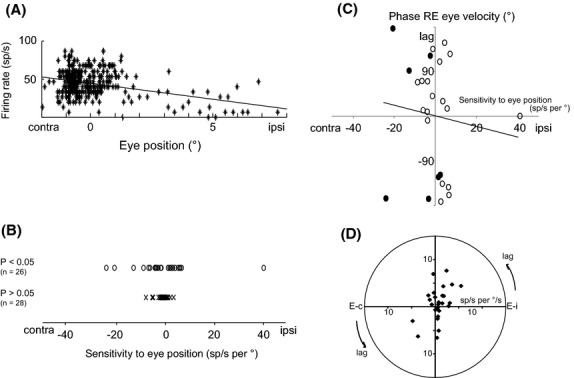
Sensitivity of Purkinje cells to eye position. (A) Example of a Purkinje cell with significant correlation between firing rate and eye position. Measurements were made during the spontaneous eye movements made by the mice while restrained with the head stationary in total darkness. Each point represents the average firing rates and eye position measured during a single, 150-ms period. Positive values on the x-axis indicate eye position ipsiversive to the recording site. The line indicates the linear regression between firing rate and eye position. (B) P-values and slopes of the linear regression between firing rate and eye position for each Purkinje cell tested. Twenty-six of fifty-four Purkinje cells showed significant correlation between firing rate and eye position. (C) The phase of firing relative to ipsiversive peak eye velocity during the OKR (ordinate), plotted as a function of the sensitivity to eye position (abscissa), in the 26 Purkinje cells with significant eye position sensitivity (ovals in panel B). Open and filled ovals indicate Purkinje cells categorized as E-i and E-c in Figure3A respectively. There was no significant correlation between the phase of the peak firing and the sensitivity to eye position (R = 0.012, p > 0.50). (D) Sensitivity to eye velocity, calculated with a correction for sensitivity to eye position, in the 26 Purkinje cells with significant eye position sensitivity (compare with Fig.3A). Results are plotted in polar coordinates, with distance from the origin representing the amplitude of eye velocity sensitivity, in spikes/s per °/s, and the angle representing the phase of peak sensitivity, with a phase of 0° indicating peak firing during peak ipsiversive eye velocity.